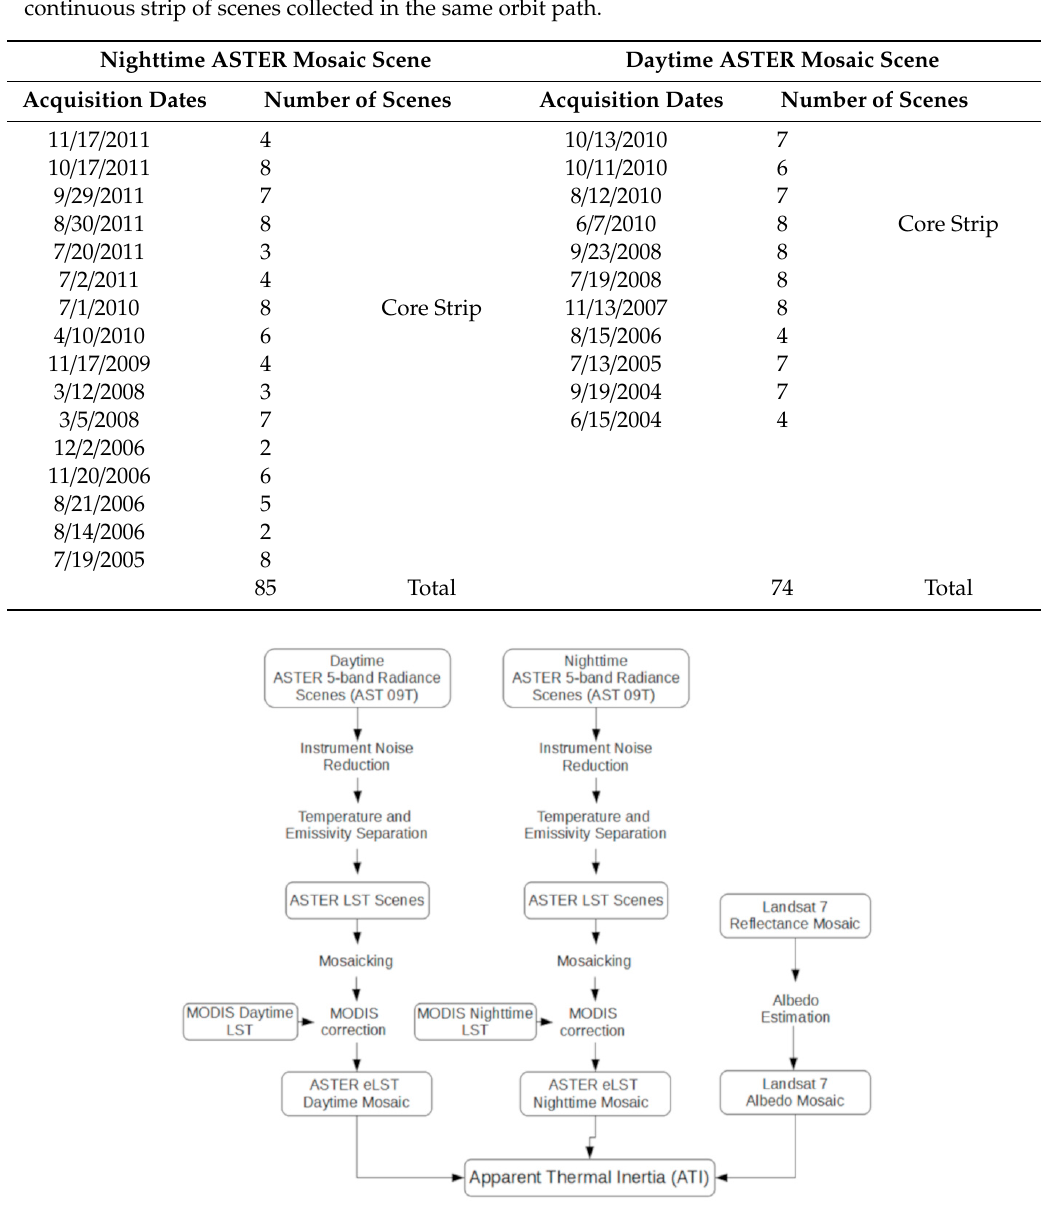
Figure 3. Workflow diagram for the ASTER, MODIS and Landsat-derived ATI map for the Mojave Desert. Closed boxes contain data products, and process steps are listed in the order of processing.